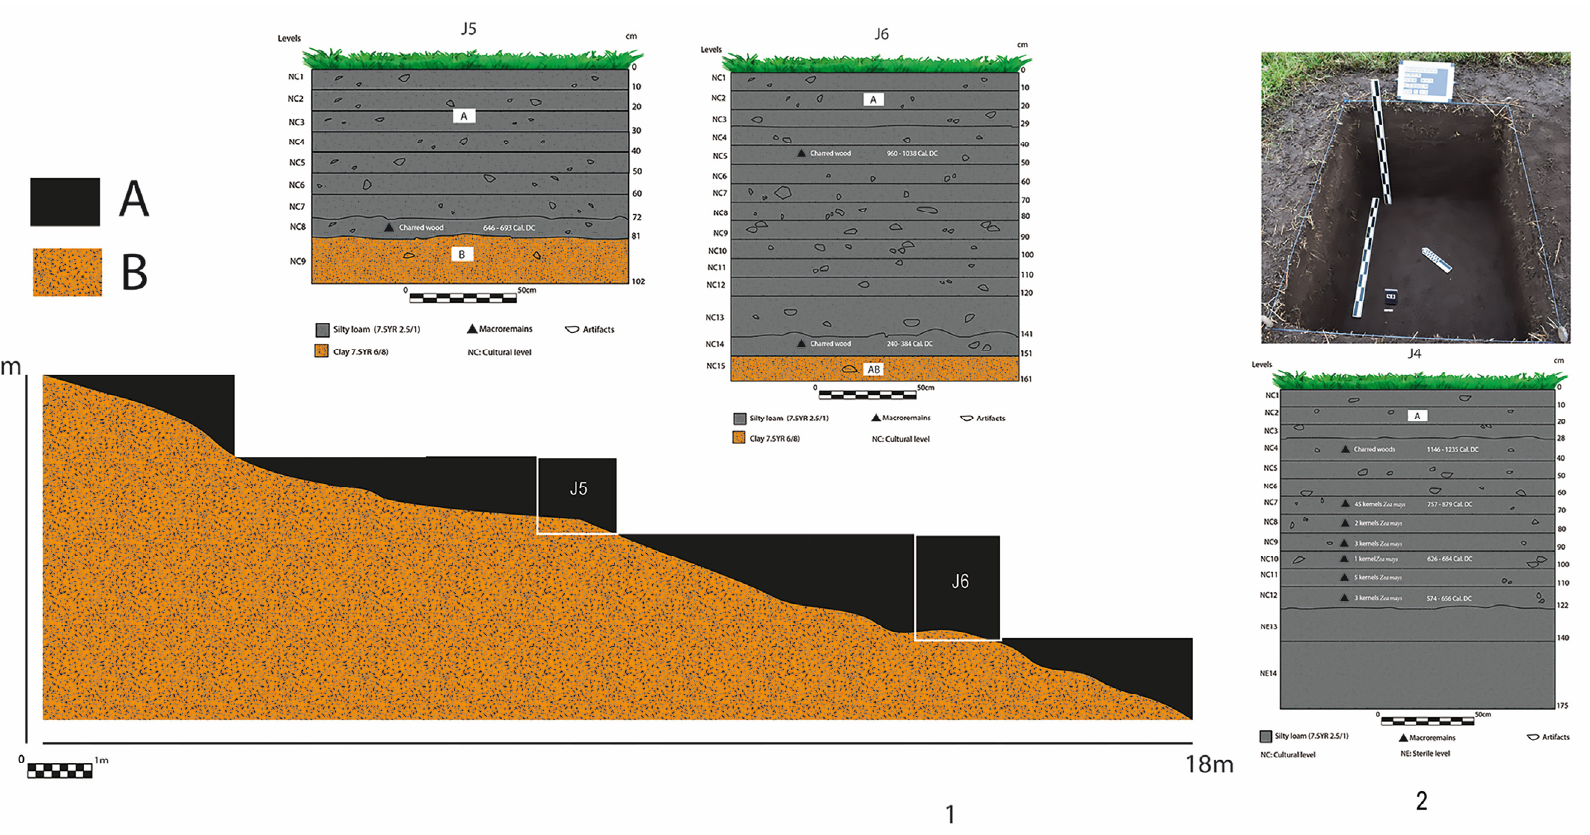
Figure 10. Stratigraphic profiles of units J4, J5, and J6 of the Joyagzhí terraces. (1) Sedimentary sections of units J5 and J6. (2) Profile and photograph of unit J4. (A) Organic sediment horizon. (B) Alluvial horizon.